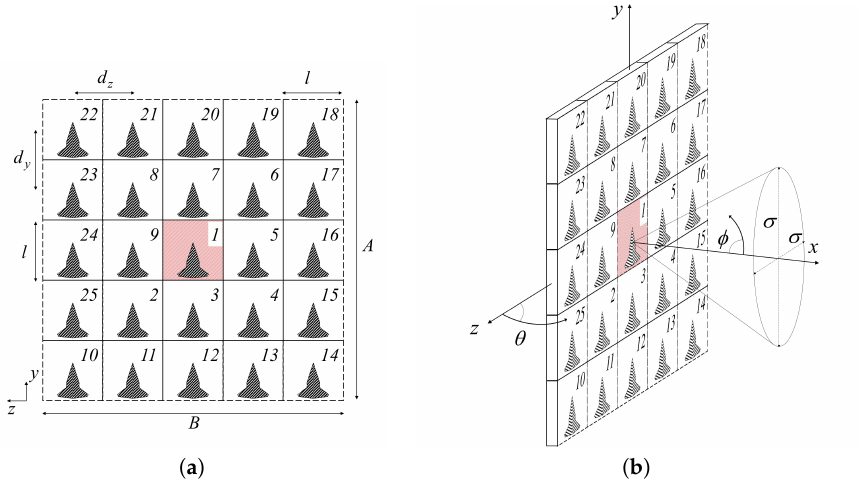
Figure 1. Front view ( a ) of the 28-GHz planar array for 5G base stations and ( b ) reference coordinate system, showing the considered elements numbering for identifying the central embedded element ( n = 1) and the surrounding radiators ( n = 2, ..., N =